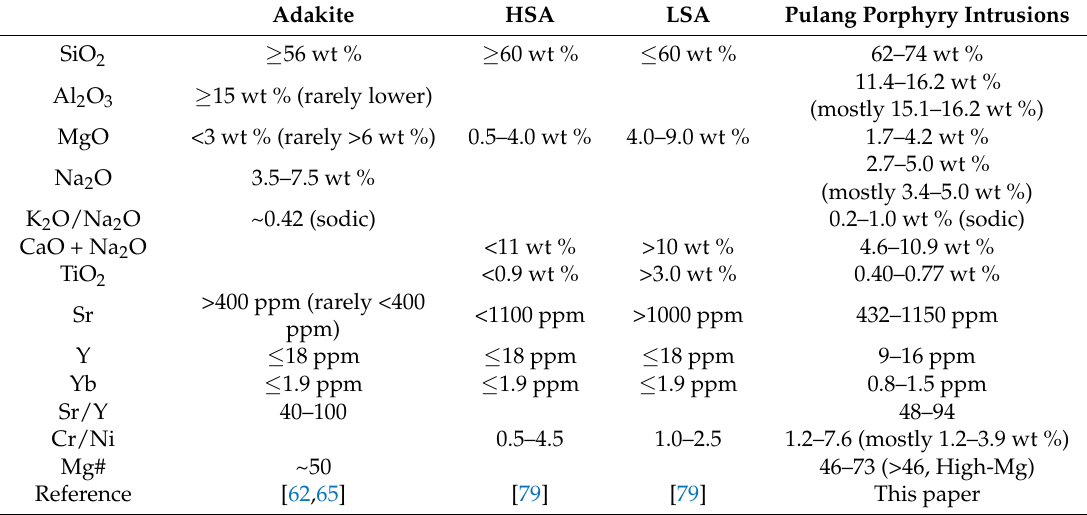
Table 4. Comparisons of geochemical characteristics between the adakite, high-SiO 2 adakites (HSA), low-SiO 2 adakites (LSA), and Pulang porphyry